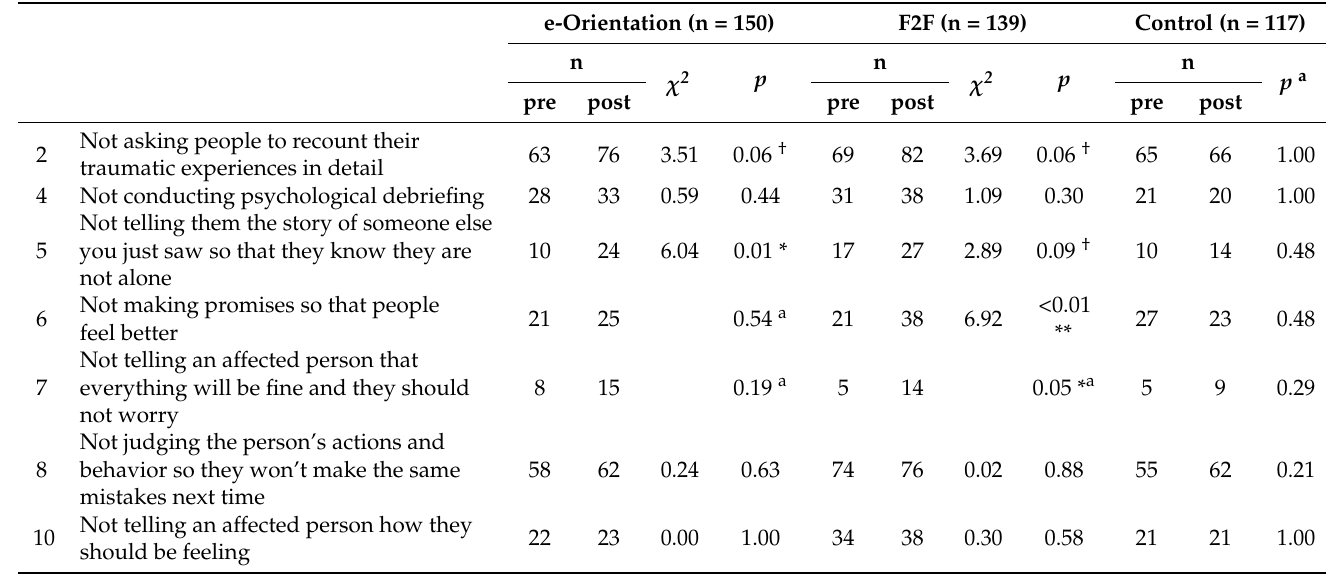
Table 2. The comparison of the number of correct answers between the pre- and post-interventions (n =